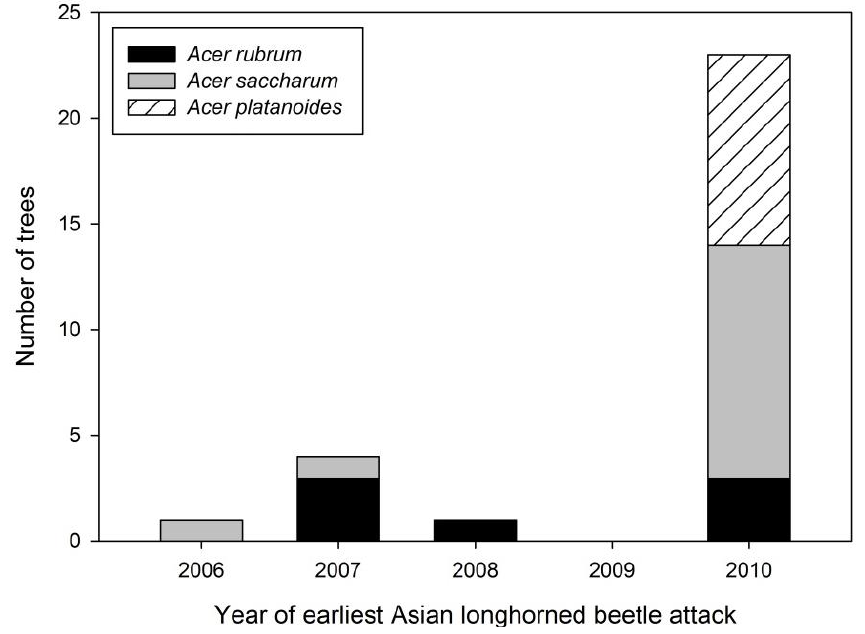
Figure 5. Distribution of age of earliest Asian longhorned beetle attack by Acer species in Boylston.